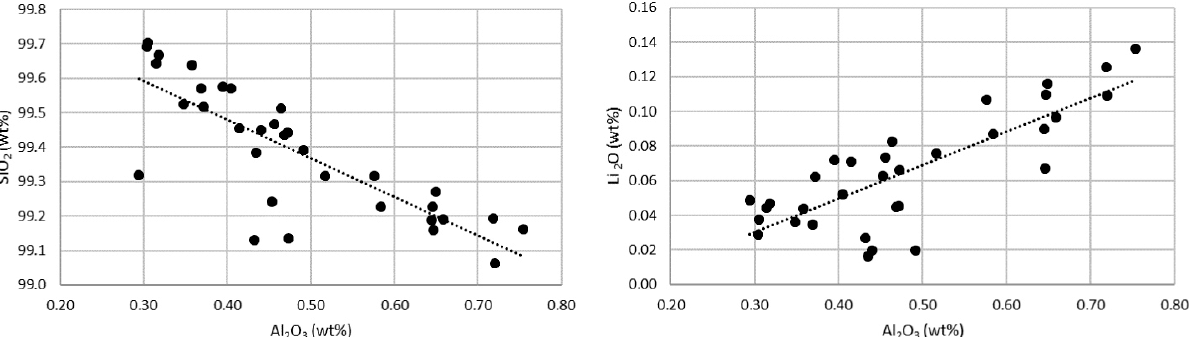
Figure 7. To illustrate fractionation trends between Si and substituting elements such as Al and Li the concentration of respective elements from all 33 measured spots were compared. The SiO 2 vs. Al 2 O 3 plot on the left reveals a negative correlation between Si and Al concentration in quartz in general, which may reflect a replacement of Si by Al and a monovalent cation. This observation is supported by the Li 2 O vs. Al 2 O 3 plot on the right, which proves a positive correlation between Li and